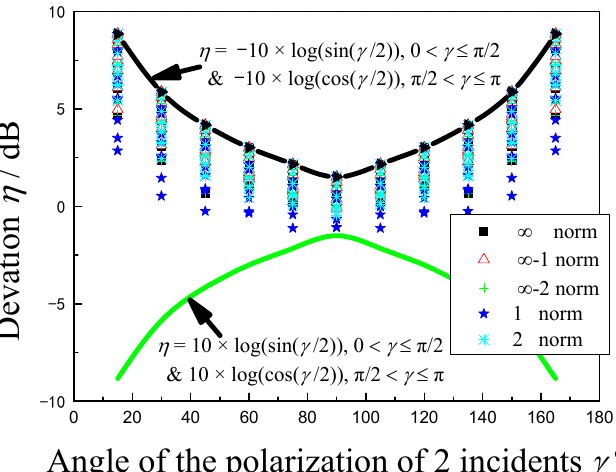
Figure 7. The deviations of the maximum couplings obtained by the approximate test method based on different norms.